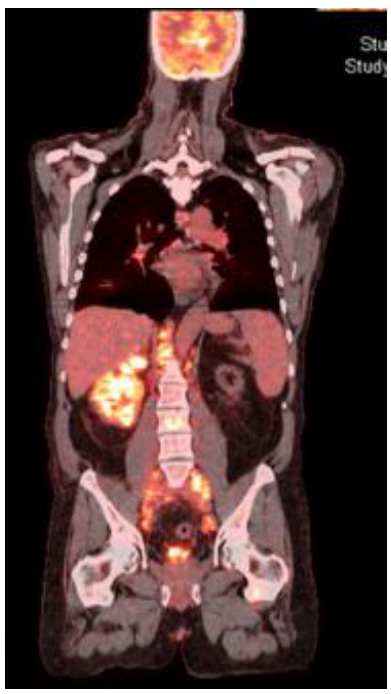
Figure 2. PET scan: Abnormal uptake in T11, L3 and the right acetabulum; significant supraclavicular, mediastinal and retrocrural adenopathy in addition to the extensive retroperitoneal adenopathy; abnormal enlargement of right